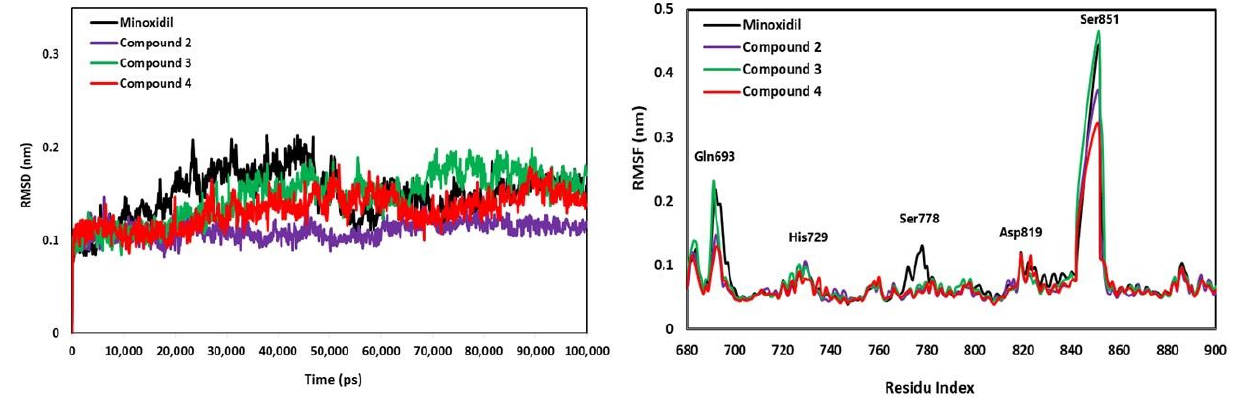
Figure 9. The graph of RMSD and RMSF from each compound in complex with the androgen receptor.